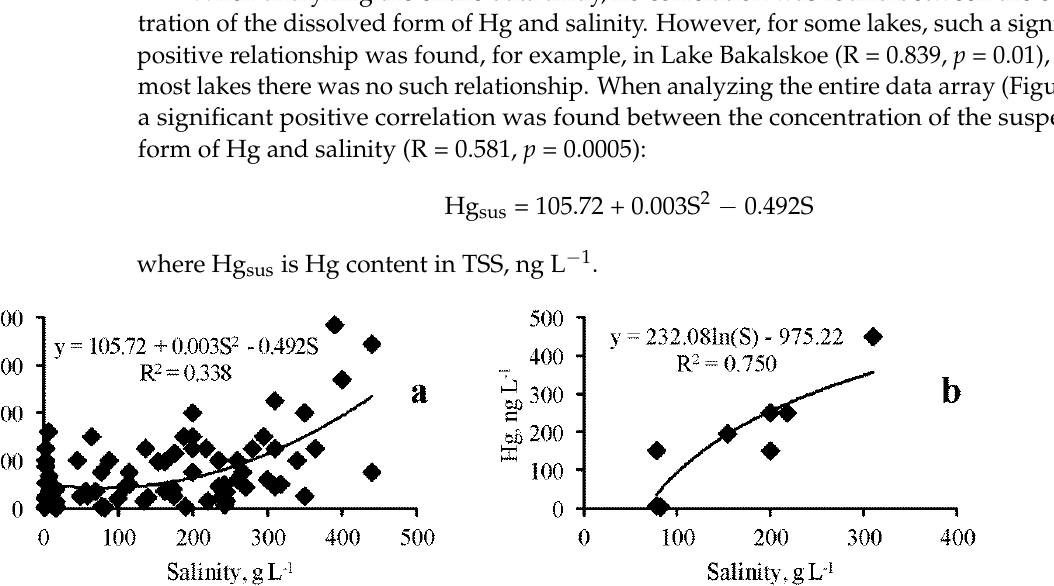
8 of 17 Figure 4. Seasonal changes in the Hg total content (red squares) and suspended form (blue rhom- bus) in the lakes Kiyatskoe ( a ) and Kirleutskoe ( b ). The concentrations of Hg dissolved and in suspended forms do not significantly correlate with each other in the total data set; however, in some lakes, a significant posi- tive correlation was observed, as, for example, in Lake Bakalskoe (R = 0.840, p = 0.01), Lake Kirleutskoe (R = 0.805, p = 0.01), Kyzyl-Yar (R = 0.755, p = 0.02), Sasyk-Sivash (R = 0.831, p = 0.01), and others. In some lakes, for example, Dzharylgach or Akhtashskoe, this dependence did not exist.